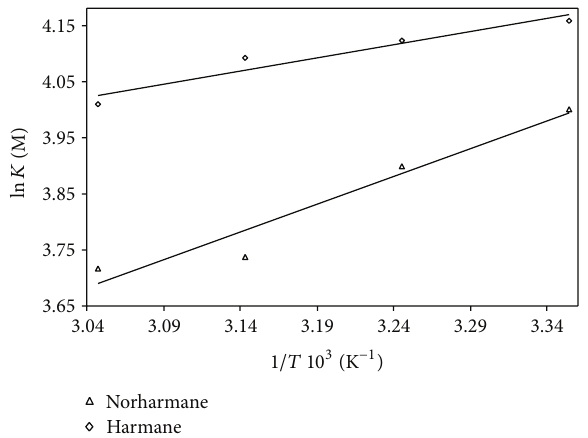
Figure 21: Van’t Hoff plots for the C38 steel/indoles/1M HCl system evaluated from